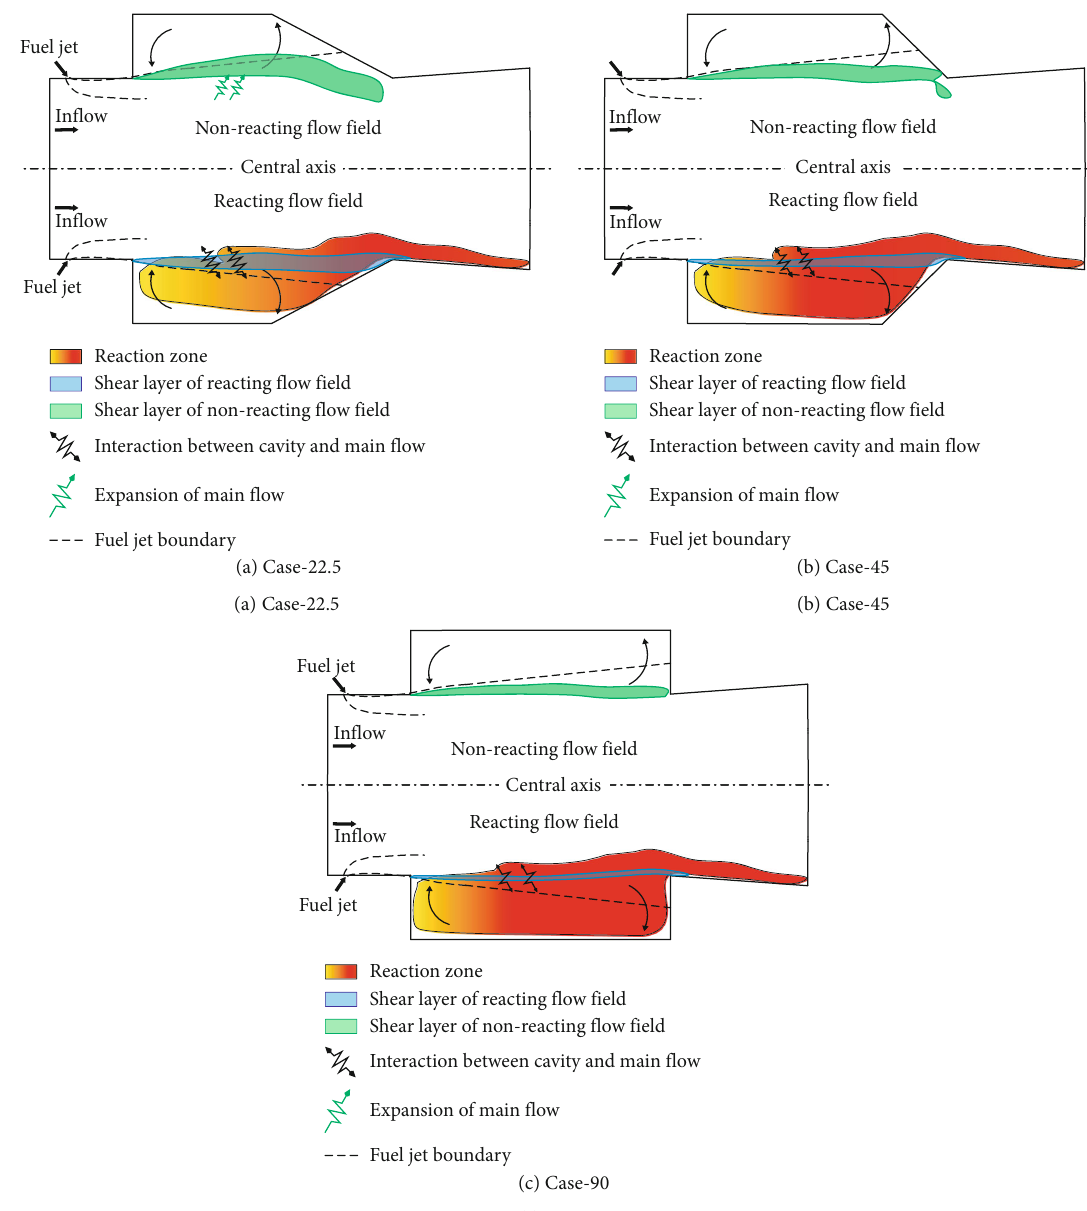
Figure 16: Schematic of fuel mixing and combustion characteristics for all